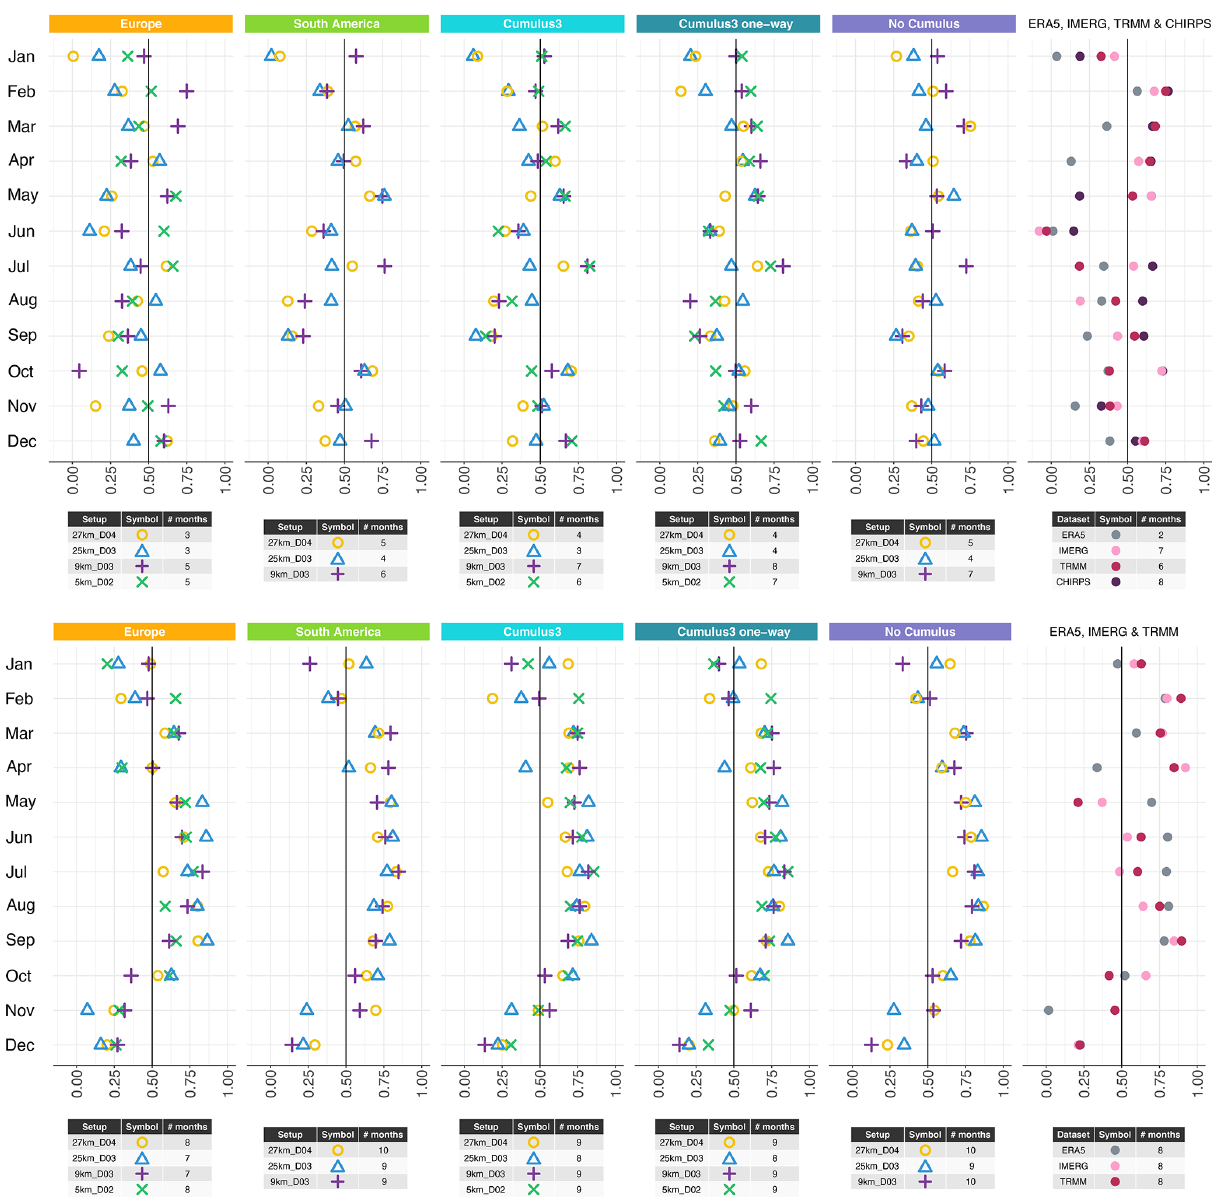
Figure 4. Pattern correlation of monthly precipitation sums for the year 2008 between weather station data and the respective WRF simulation (upper row) and between CHIRPS and the respective WRF simulation (interpolated onto the CHIRPS grid, lower row). The different panels indicate the different parameterization options (Table 1), and the symbols stand for the different nesting options. The labelling of the symbols is given in the table below each panel, along with the number of months (# months) in which the nesting option obtain correlation patterns above the reference value of 0.50 (a moderate correlation used to visually evaluate the performance of nesting options). The last panel on each row represents the gridded data sets used throughout the paper. Even if the gridded data sets are interpolated onto different domains for each independent setup, here only one setting is shown (27km_D04, only first row). The rest was omitted as only marginal changes can be